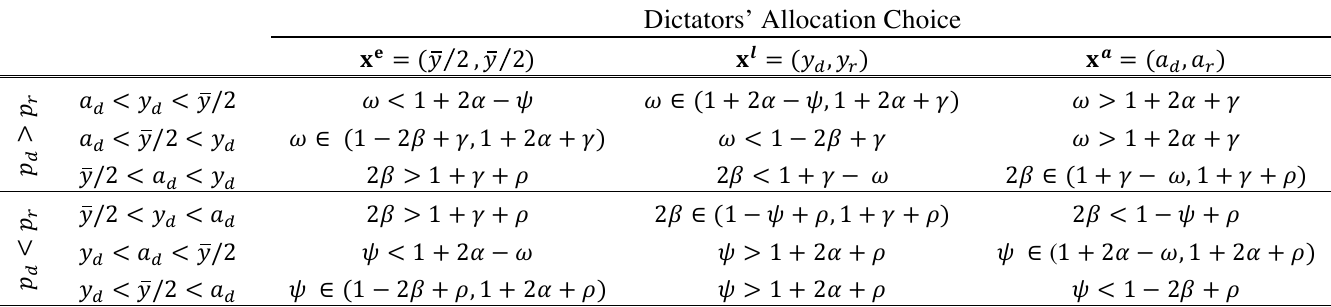
Table 1. Predictions of our